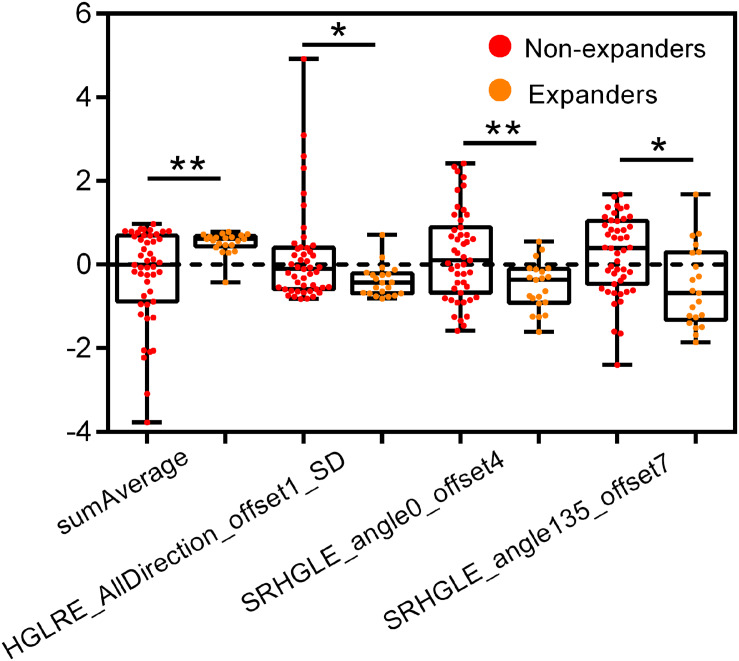
Univariate analysis of four candidate features for hematoma expansion prediction in the training cohort. HGLRE, high gray level run emphasis, SRHGLE, short run high gray level emphasis. *p < 0.01, **p < 0.001.